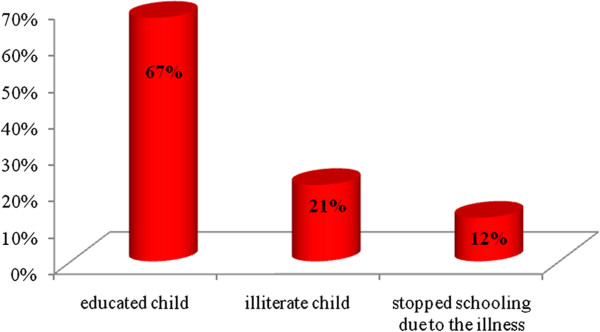
Schooling profile of patients.